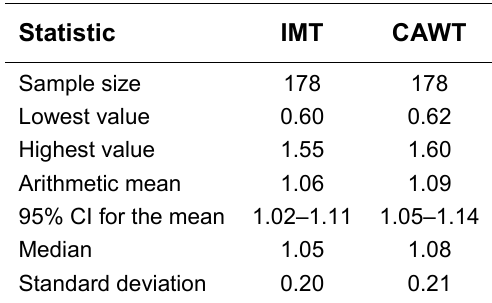
Summary Statistics in Patients Studied